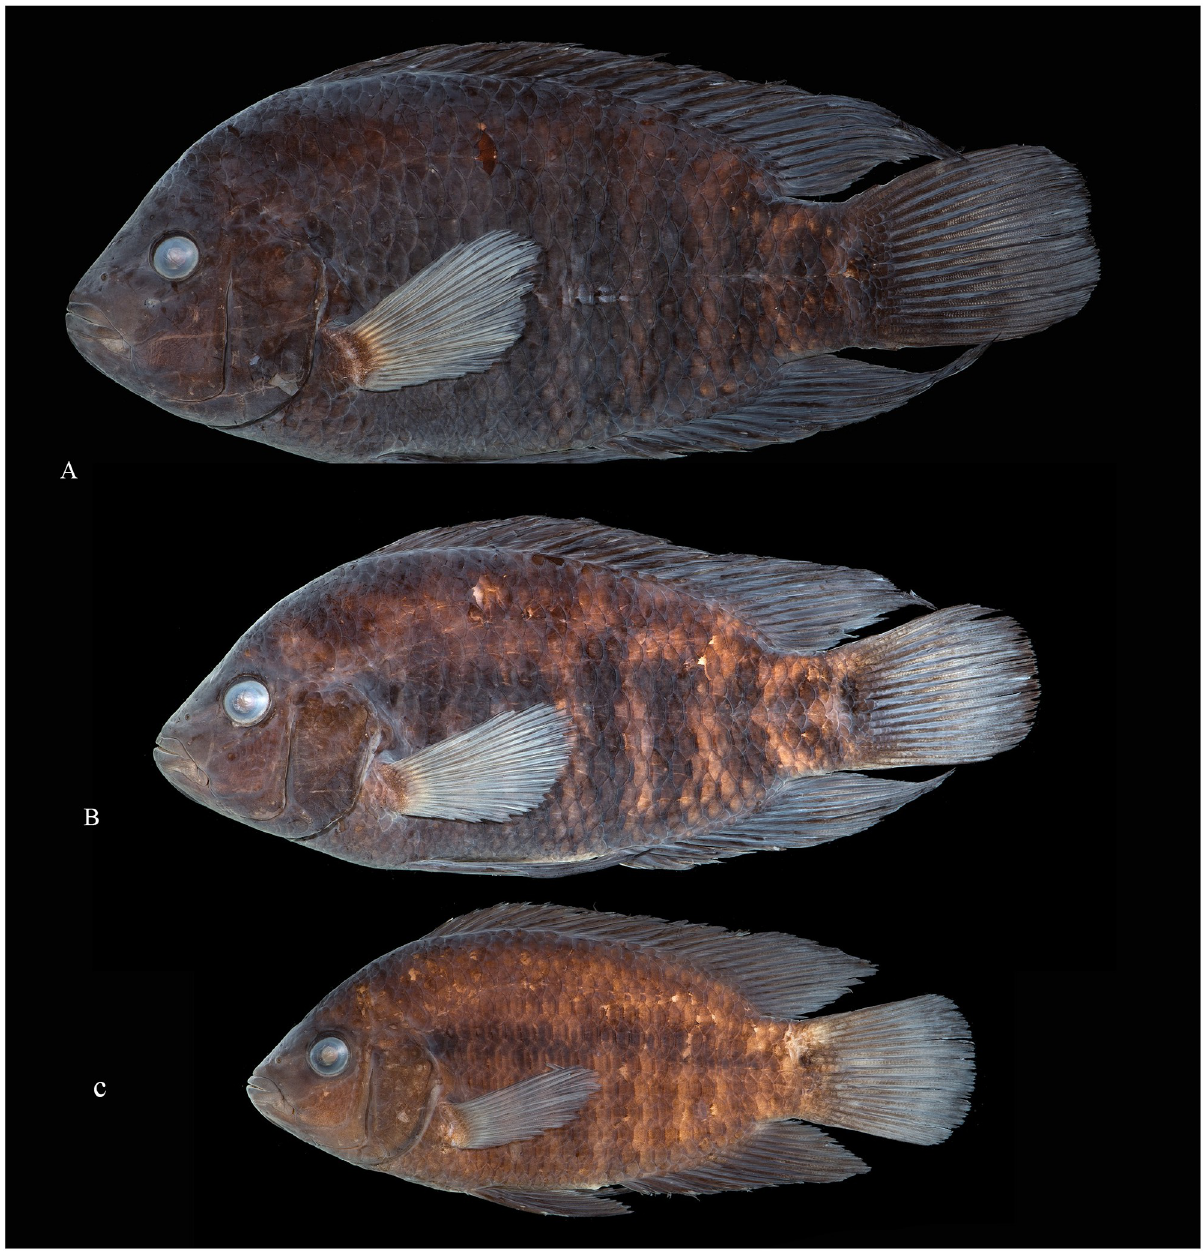
Fig 14. Australoheros facetus. A. adult male, 145.4 mm SL; NRM 55720. B adult female, 108.8 mm SL; NRM 55720. C. young female, 55.4 mm SL; NRM 55720. All from Uruguay: Maldonado: Laguna del Diario. frontal contour, in anterior half head, slightly dorsal to midaxis level of body. Gill cover with distinct indentation at dorsal junction of opercle and subopercle. Mouth terminal, below level of orbit; tip of maxilla exposed, not reaching to vertical from anterior margin of orbit. Jaws isognathous; tooth band of lower jaw closing opposite or poste- rior to upper tooth band. Lips moderately thick, both lip folds interrupted symphysially. Jaw teeth in 2–3 rows, in juveniles only one row. Six anterior teeth in outer row in both jaws slightly